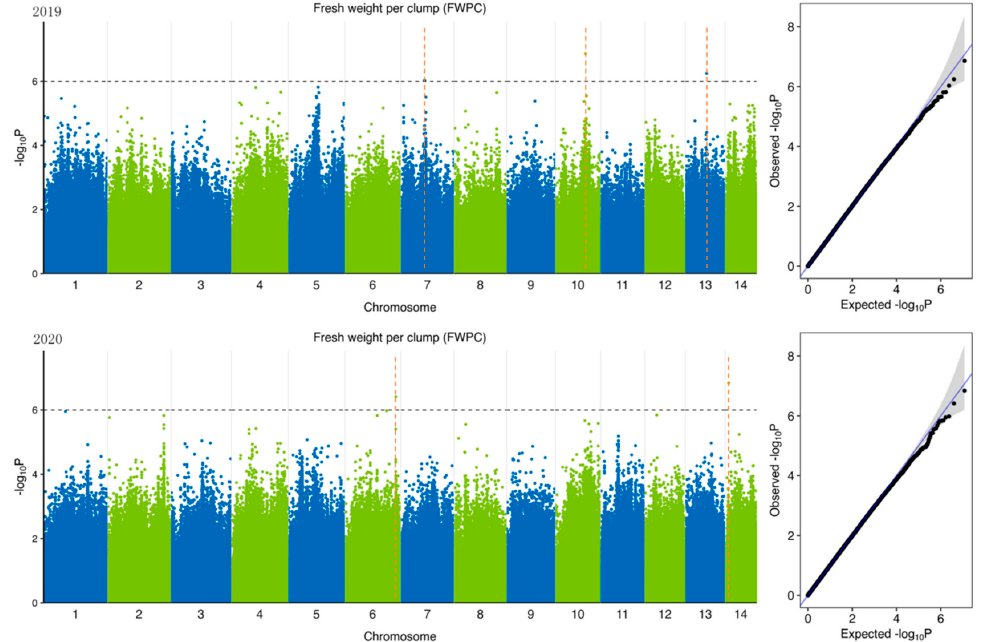
Figure 5. Manhattan plots of GWAS results for fresh weight per clump (FWPC) in 2019 and 2020. Notes: Blue and green dots represented SNP (single nucleotide polymorphism) sites on chromosomes, respectively. When the value of − log 10 p was above 6 (gray line), the selected SNP site with significant aboriginality. Orange dotted lines represented the location of SNP loci.